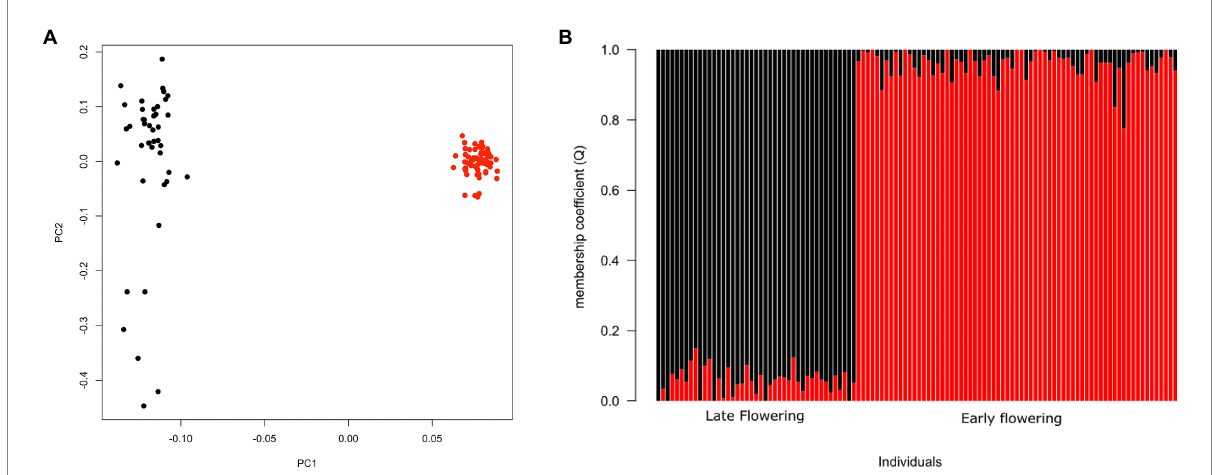
FIGURE 3 Genomic differentiation for early and late-flowering pearl millet accessions. (A) Principal component analysis (PCA) of pearl millet showing first and second principal components. (B) Genetic structure for K = 2 using sNMF. Each individual is represented by a vertical bar, partitioned into K segments representing the amount of assignment of its genome in K clusters identified by different colors. Red circles and bars correspond to EF accessions and black circles and bars characterize LF